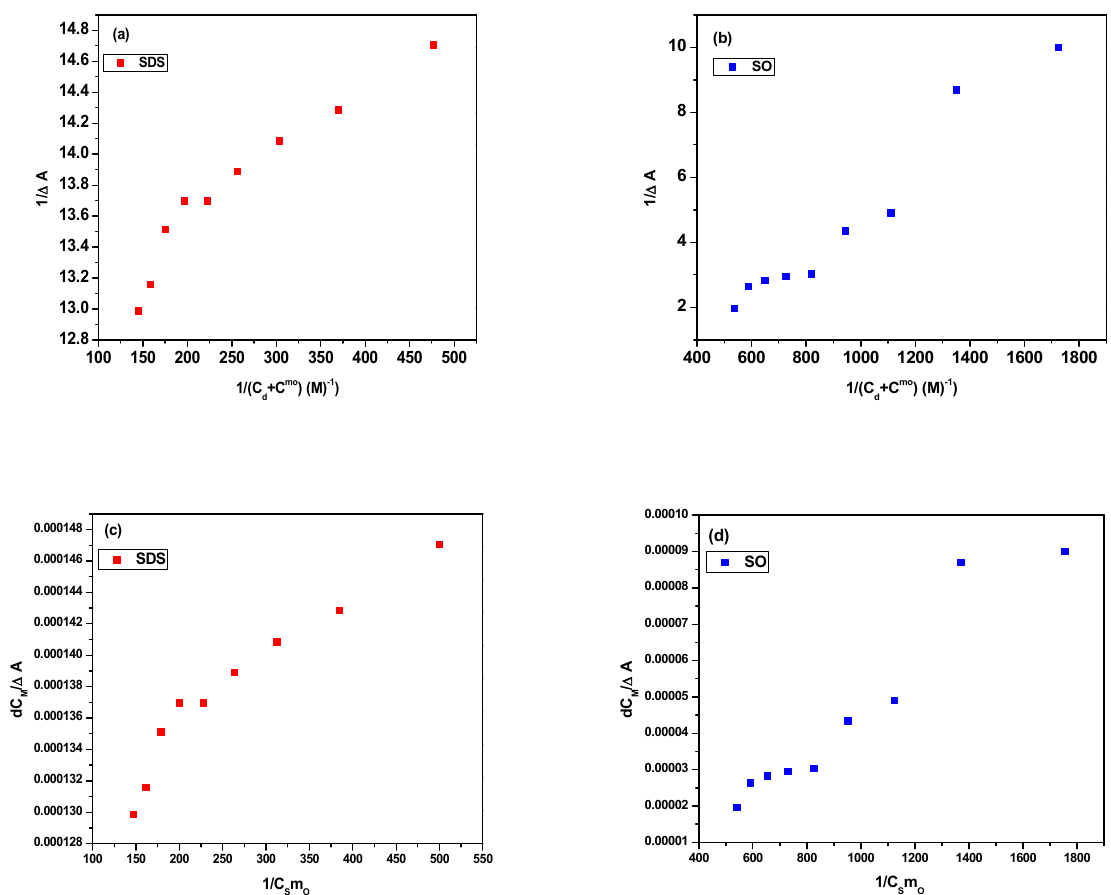
Figure 3. ( a ) Kawamura plot for calculation of partition constant, K x , for the Co 2+ /SDS system ( b ) Kawamura plot for calculation of partition constant, K x , for the Co 2+ /SO system ( c ) Benesi–Hildebrand plot for the calculation of binding constant, K b , for the Co 2+ /SDS system. ( d ) Benesi–Hildebrand plot for calculation of binding constant, K b , for the Co 2+ /SO system.